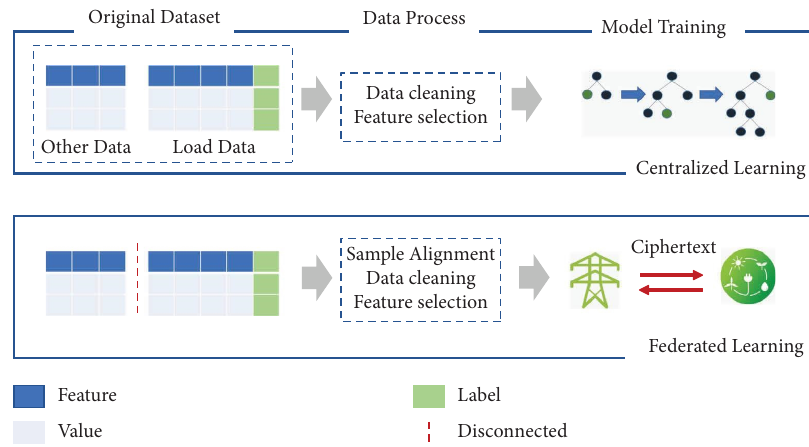
Figure 1: Pipeline of centralized learning pipeline and federated